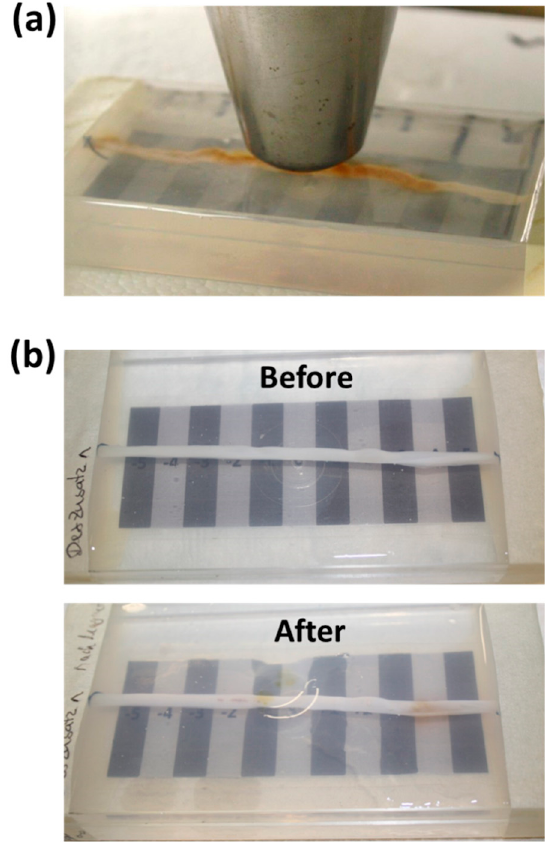
Figure A1. Ex vivo umbilical artery model: ( a ) Placement of the magnet tip; ( b ) representative macroscopic images of the artery model before and after the flow experiment.